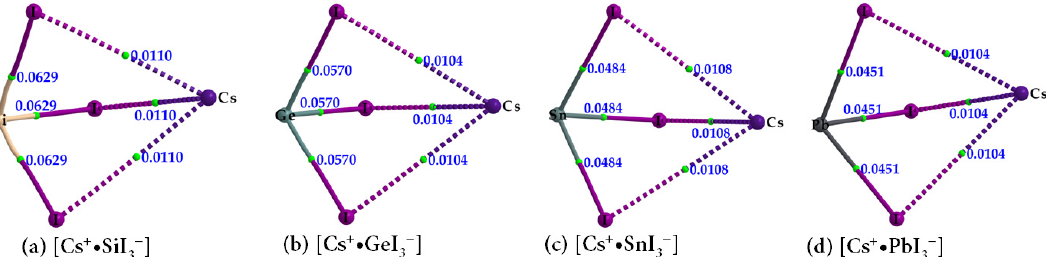
Figure 3. ( a – d ) QTAIM-based molecular graphs of cesium tetrel halide perovskite ion pairs, [Cs + •TtI 3 − ] (Tt = Si, Ge, Sn, and Pb), obtained with [ ω B97XD/def2-TZVPPD]. Values represent the charge density ( ρ b /au) at the Tt–I and Cs···I bond critical points. Atoms, bond paths, and bond critical points are shown as large spheres, solid or dotted lines in atom color, and tiny spheres in green, respectively.